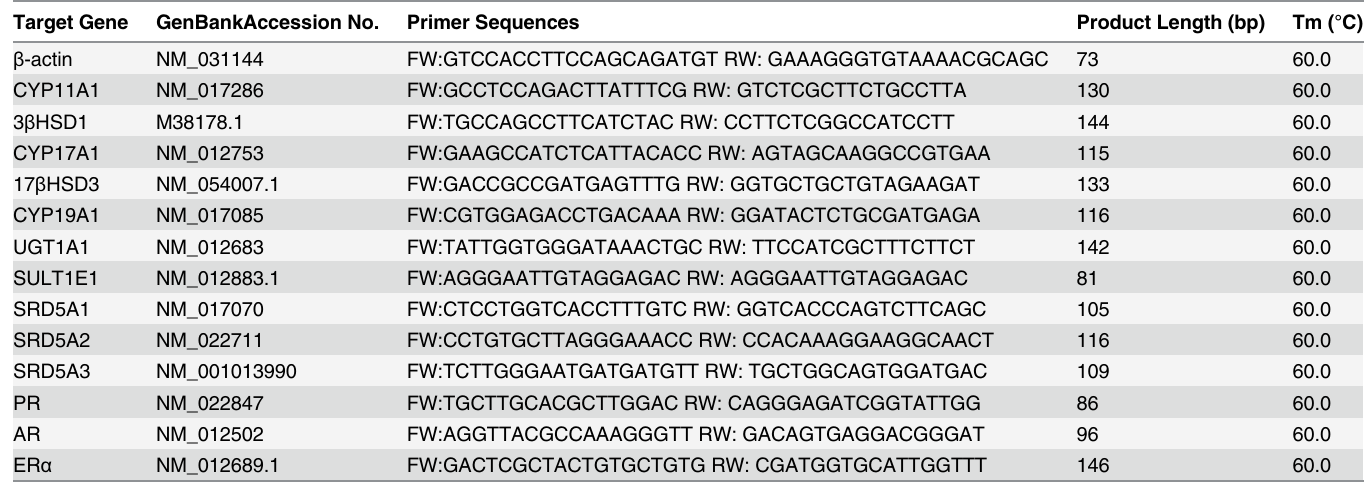
Table 1. Sequences of primers used for Q-RT-PCR amplification. Target Gene